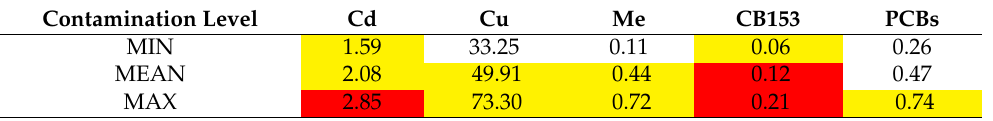
Table 5. Contamination level (mg/kg of dry sediment) of 5 main contaminants in the Rove Canal after [2]: min and max levels, and weighted means over thickness of 3 strates of sediment cores. Yellow and red colored cells correspond to overpass of regulatory thresholds of contamination (high and very high levels) after decrees of the French Ministry of Ecology of 14 June 2000 and 9 August 2006. Contamination Level Cd Cu Me